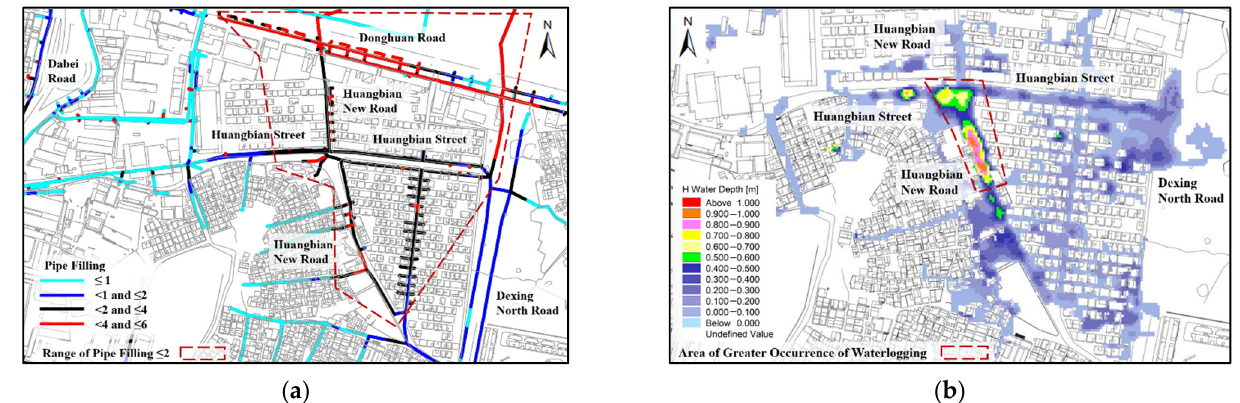
Figure 3. Simulation of waterlogging under designed rainfall conditions. ( a ) Degree of fullness of the pipe network (Pipe filling: The pipe filling is calculated as the depth divided by the pipe height,